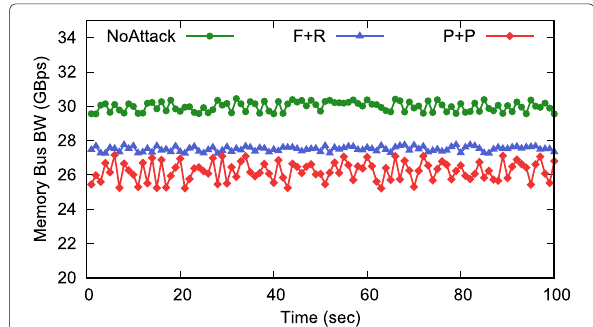
Fig. 8 Memory bandwidth during Flush+Reload and Prime+Probe attacks, as measured using Poker. The figure shows the decrease in bandwidth measured by Poker on the victim VM when Flush+Reload and Prime+Probe attacksarelaunched independently from the attacker VM